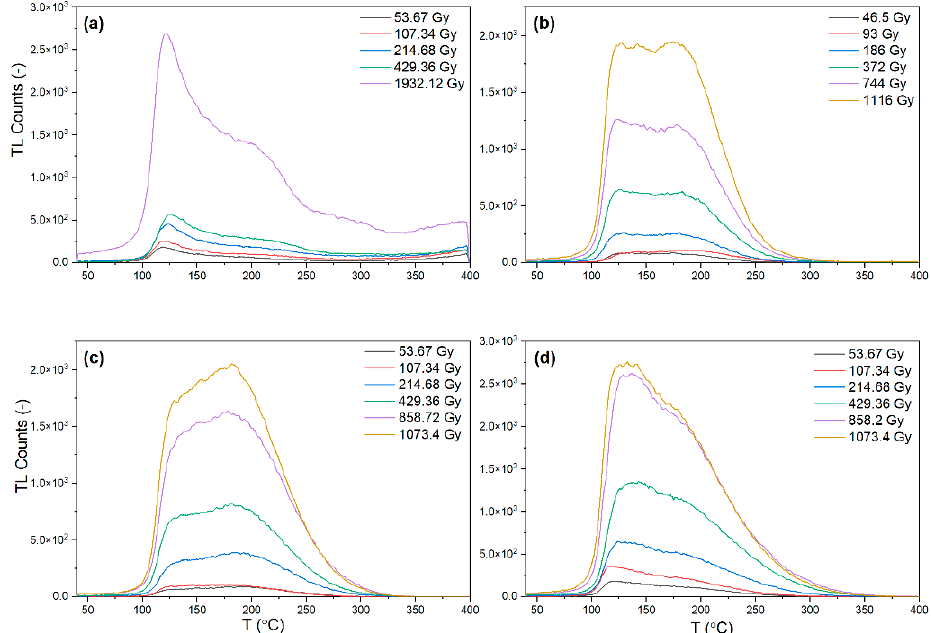
Figure 4. TL curves for samples irradiated using beta radiation (17 ns pulse duration), PPG ( a ), PPG_Tb01 ( b ), PPG_Tb05 ( c ), and PPG_Tb30 ( d ). PPG samples were read without shutter.